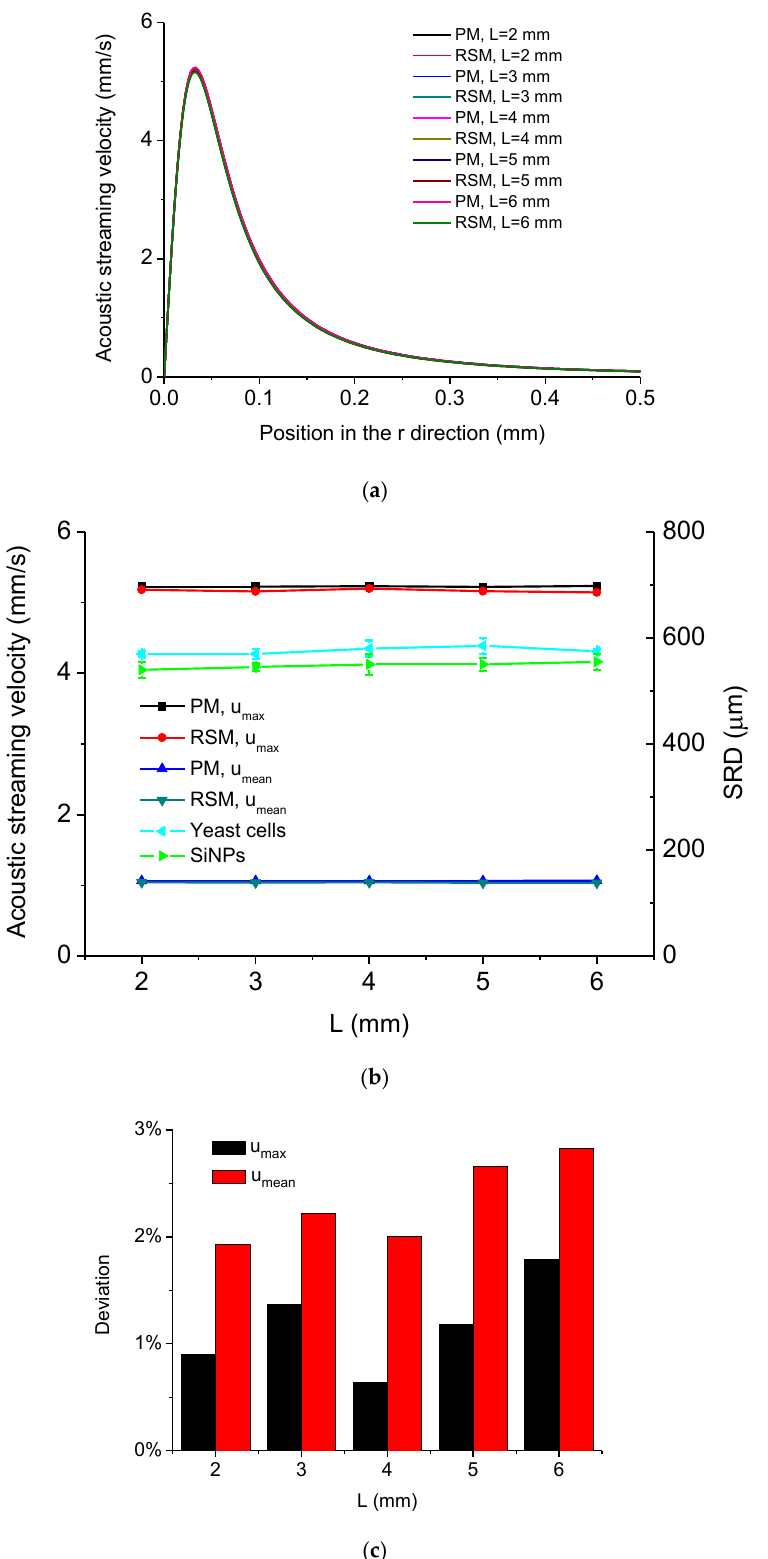
Figure 9. ( a ) Computed acoustic streaming velocity distribution along the r direction at the droplet-substrate interface in the ultrasonic probe-droplet-substrate system under di ff erent L . ( b ) u max , u mean and SRD versus L in the ultrasonic probe-droplet-substrate system. ( c ) Deviations of u max and u mean computed by the PM and RSM versus L in the ultrasonic probe-droplet-substrate